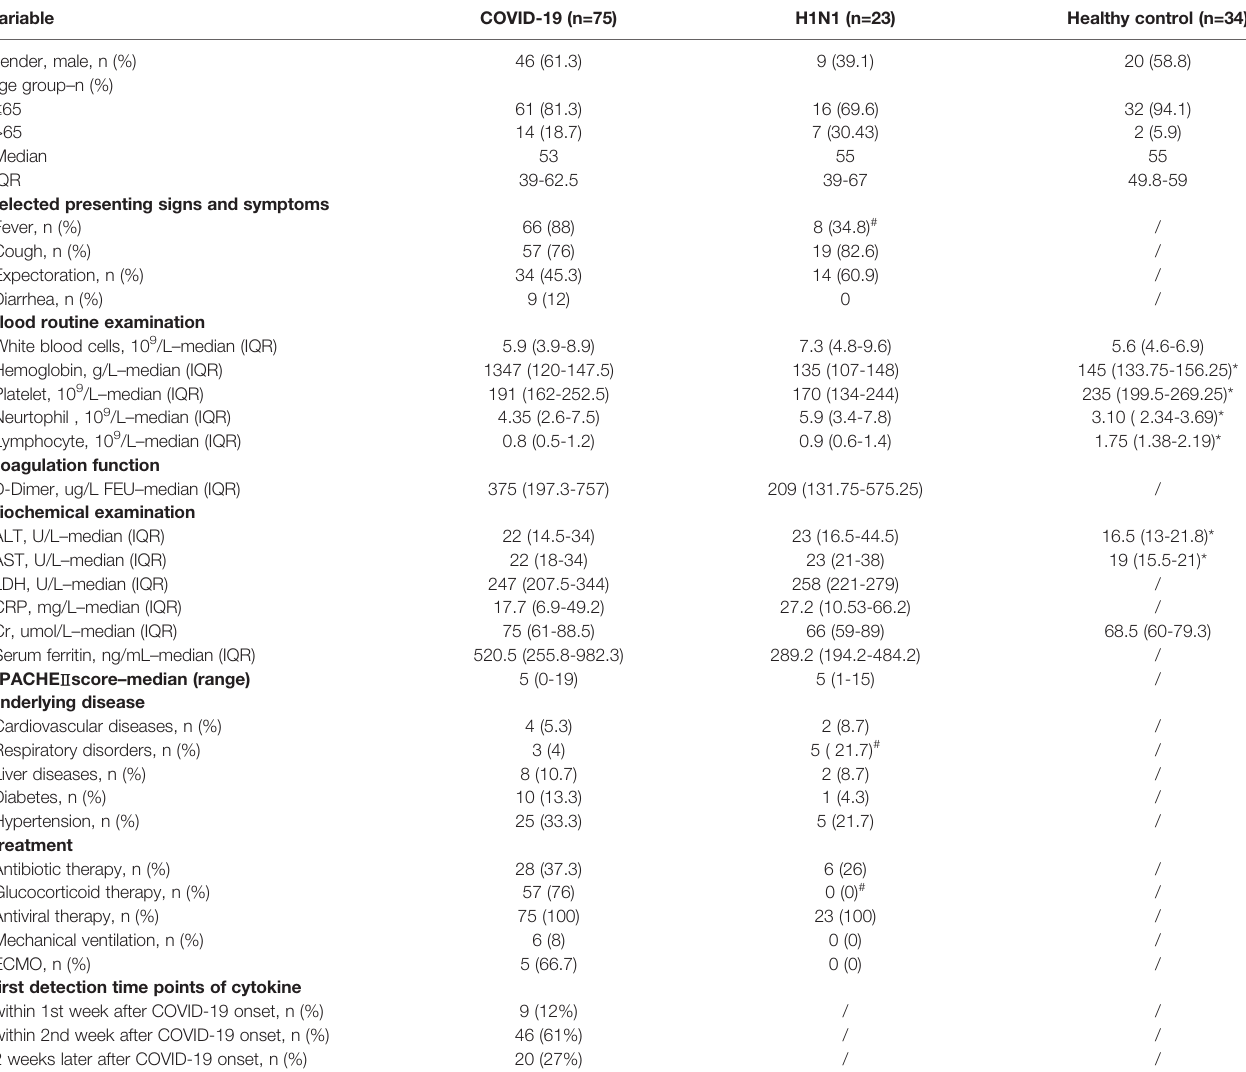
TABLE 1 | Clinical characteristics of subjects including COVID-19 patients, H1N1 patients and healthy controls in this